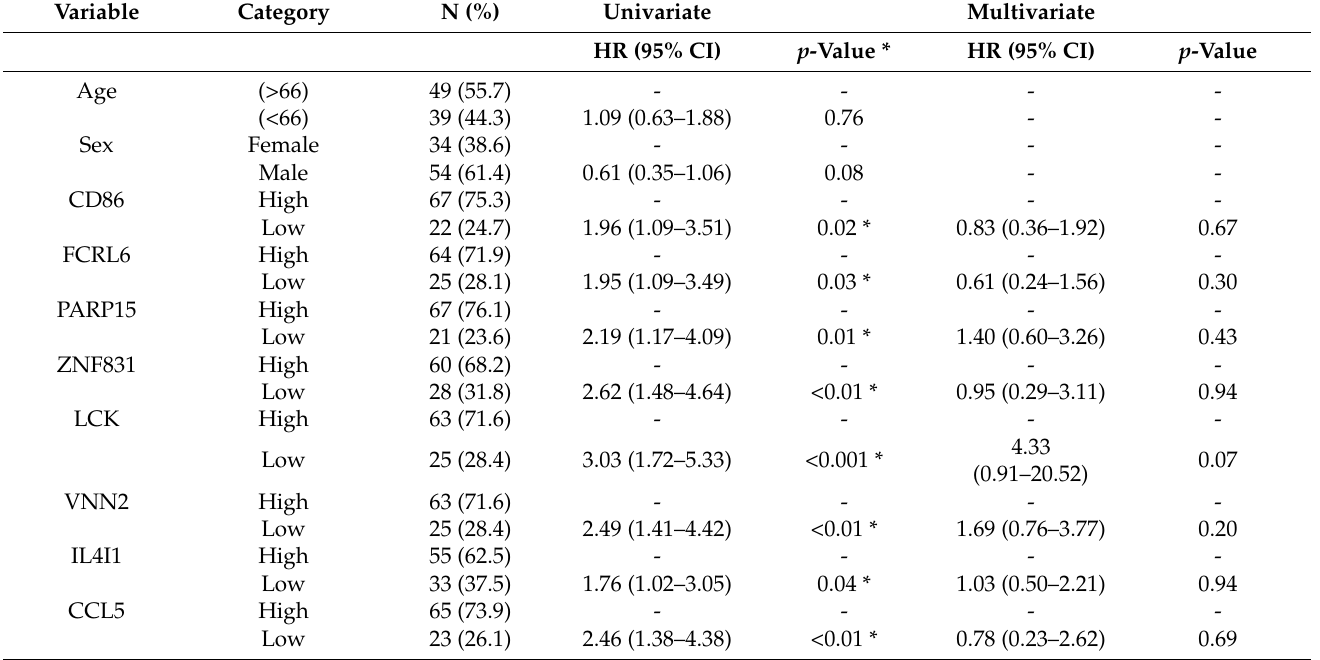
Table 3. Univariate and multivariate cox proportional hazard model for